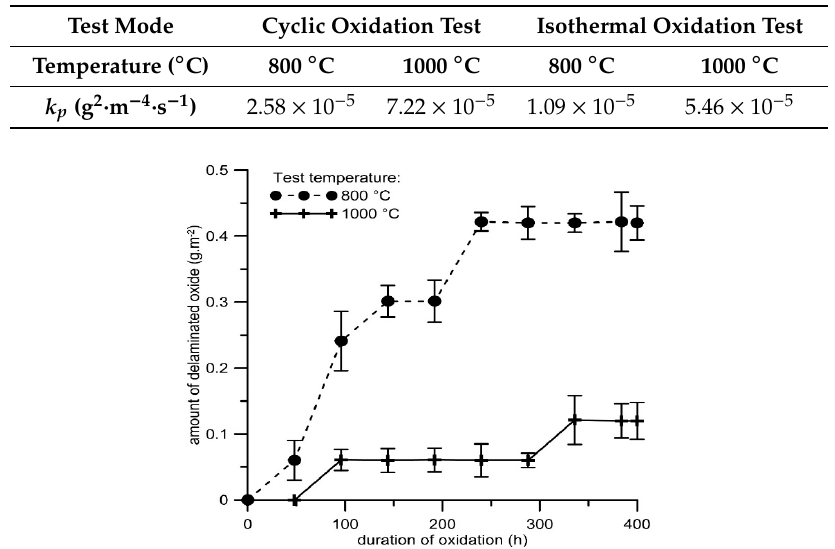
Figure 7. Dependence of specific weight gain (g m 2 ) on duration of cyclic oxidation at 800 and 1000 ◦ C in air for FeAl20Si20 alloy, with the squared value of specific weight gain vs. time as insert. Table 4. Parabolic rate constants ( k p ) of isothermal and cyclic oxidation at 800 and 1000 ◦ C.